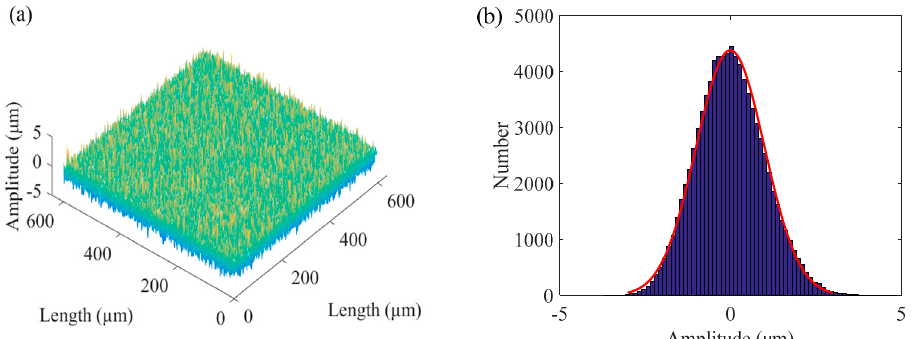
Figure 1. A simulated non ‐ Gaussian rough surface: ( a ) non ‐ Gaussian rough surface.;( b ) histogram of the non ‐ Gaussian rough surface. the non-Gaussian rough